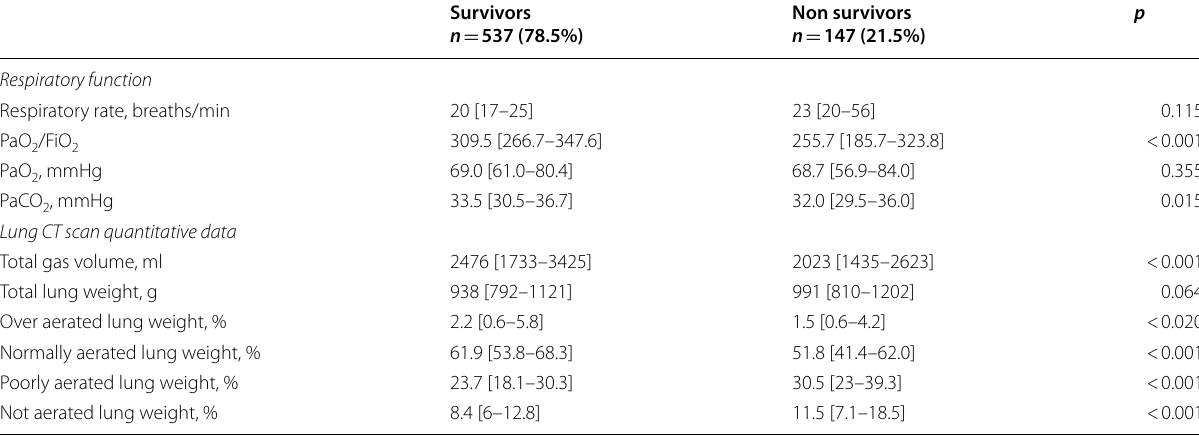
Continuous variables are expressed as median [IQR] and compared with Mann–Whitney U test FiO 2 inspired fraction of O 2 , PaO 2 arterial partial pressure of O 2 , PaCO 2 arterial partial pressure of CO